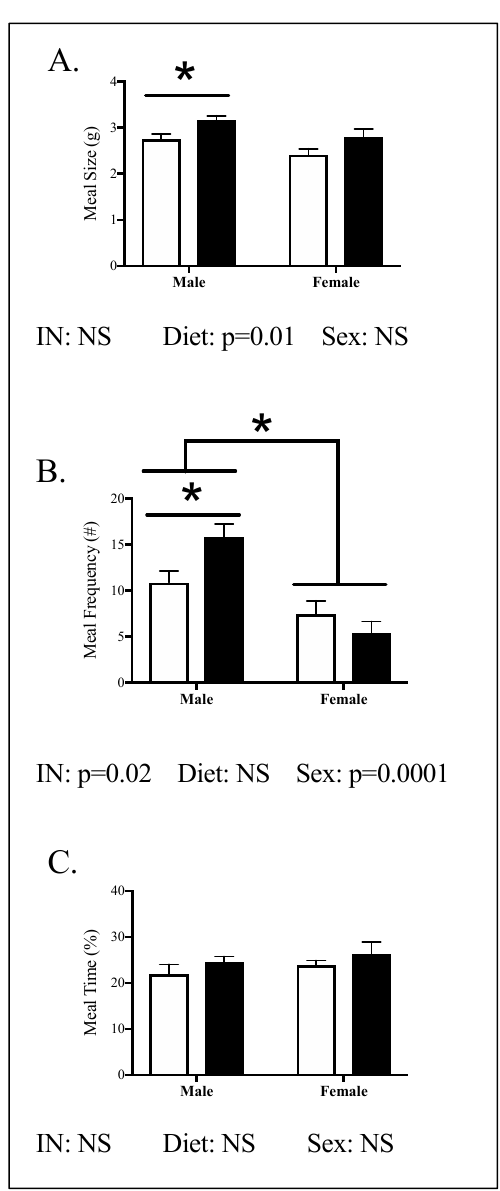
Figure 4. Offspring energy intake in peripubertal mice following maternal HFHC-diet-induced Figure 4. O ff spring energy intake in peripubertal mice following maternal HFHC-diet-induced obesity. obesity . Meal size (Panel A ), meal frequency (Panel B ), and time spent eating (Panel C ) were measured Meal size ( A ), meal frequency ( B ), and time spent eating ( C ) were measured in male and female in male and female offspring born to CON and HFHC dams, following weaning. HFHC males had o ff spring born to CON and HFHC dams, following weaning. HFHC males had 15% larger meals 15% larger meals and 46% more meals than CON males (Panels A , B ). There were no significant and 46% more meals than CON males ( A , B ). There were no significant di ff erences between the CON differences between the CON and HFHC females (Panels A – C ). Male and female offspring born to and HFHC females ( A – C ). Male and female o ff spring born to HFHC dams had increased meal size, HFHC dams had increased meal size, compared to CON male and female offspring ( p = 0.01, Panel compared to CON male and female o ff spring ( p = 0.01, A ). This e ff ect of diet was not seen in male and A ). This effect of diet was not seen in male and female offspring in meal frequency or time (Panels B , C ). Males had an increased meal frequency compared to females ( p = 0.0001, Panel B ). There was an female o ff spring in meal frequency or time ( B , C ). Males had an increased meal frequency compared interaction between diet (CON vs. HFHC) and sex (male vs. female) in meal frequency (Panel B ). to females ( p = 0.0001, B ). There was an interaction between diet (CON vs. HFHC) and sex (male vs. Results are expressed as mean ± SEM. CON—offspring born to dams maintained on control diet; female) in meal frequency ( B ). Results are expressed as mean ± SEM. CON—o ff spring born to dams HFHC—offspring born to dams maintained on high-fat–high-carbohydrate diet. Open bars represent maintained on control diet; HFHC—o ff spring born to dams maintained on high-fat–high-carbohydrate CON offspring; closed bars represent HFHC offspring; unpaired t -test or two-way ANOVA, followed diet. Open bars represent CON o ff spring; closed bars represent HFHC o ff spring; unpaired t -test or by post-hoc Tukey’s HSD; n = 4–6/group, vs. offspring born to dams consuming same diet (diet effect), two-way ANOVA, followed by post-hoc Tukey’s HSD; n = 4–6 / group, vs. o ff spring born to dams consuming same diet (diet e ff ect), vs. male o ff spring born to dams consuming di ff erent diets (sex e ff ect); * p < 0.05, p values > 0.1 were recorded as non-significant